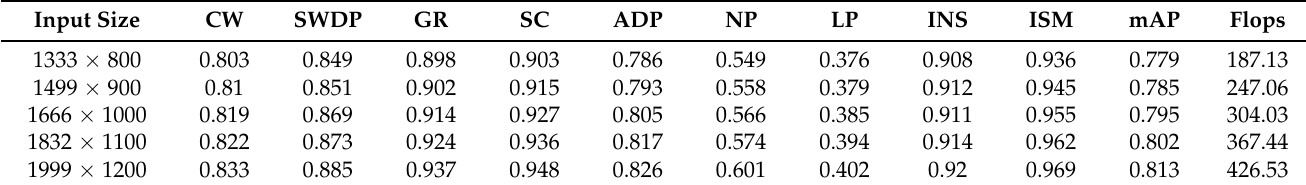
Table 4. Detection results of objects with different image sizes.